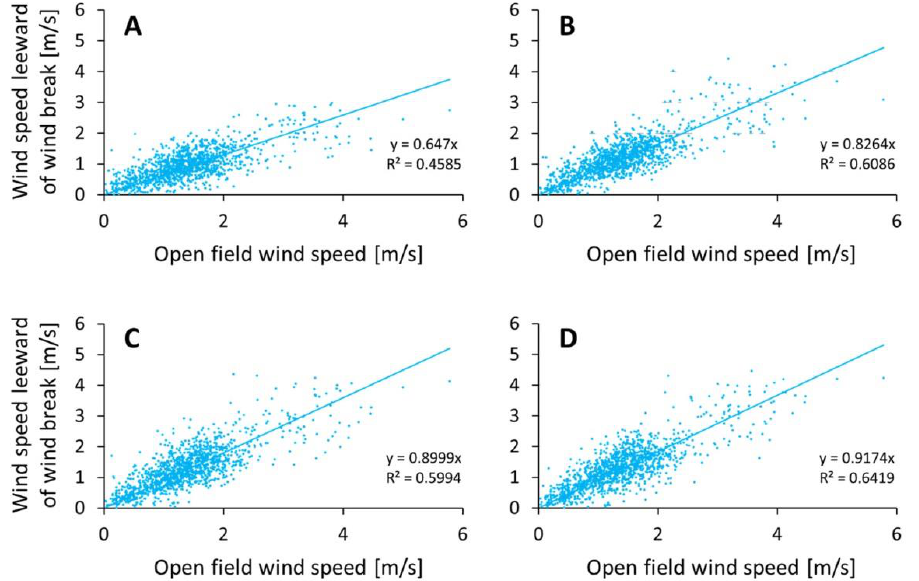
Figure 6. Wind speed of open field conditions (Wind speed open field ) versus wind speed (Wind speed wind break ) leeward of the single row tree wind break at the following distances from the tree wind break: 13.7 * H (in subgraph A ), 21.25 * H (in subgraph B ) 26.8 * H (in subgraph C ), and 30 * H (in subgraph D ). Distances are expressed in multiples of the wind break tree height (H).